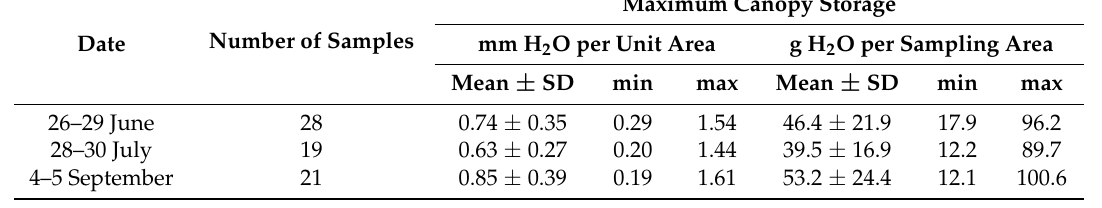
Table 1. Maximum canopy storage in mm H 2 O per unit area and in g H 2 O per sampling area measured in 3 field campaigns.